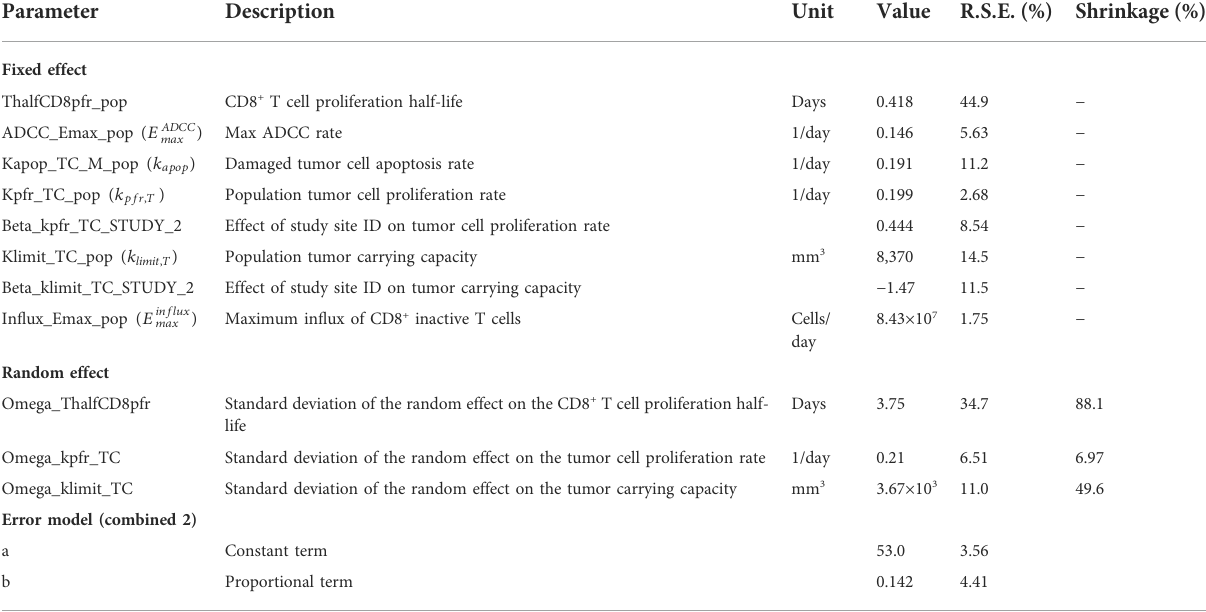
TABLE 2 Fitted model parameters. Parameter symbols used in the equations are shown in parentheses.